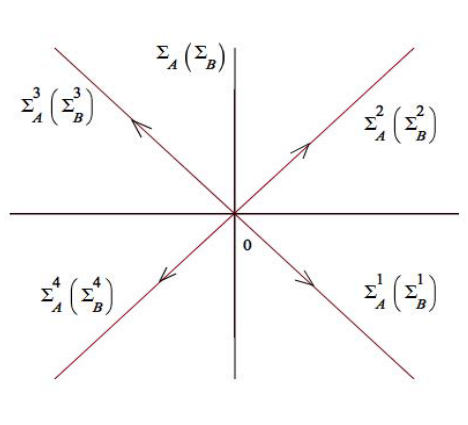
Figure 9. Oriented contours Σ A and Σ B